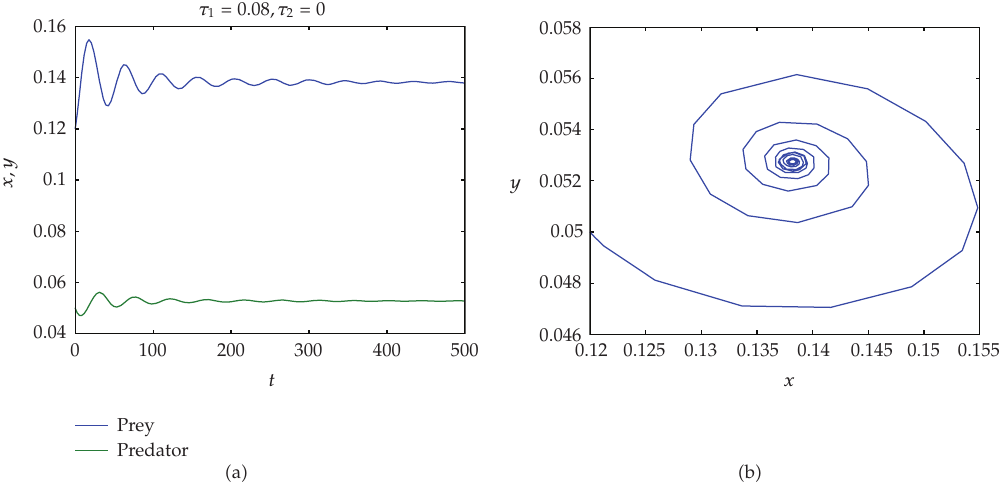
Figure 2: a (cid:8) 1 . 4, b (cid:8) 0 . 4, d (cid:8) 0 . 5, e (cid:8) 0 . 05, and l (cid:8) m (cid:8) d 1 (cid:8) d 3 (cid:8) 0 . 5. E ∗ is asymptotically stable